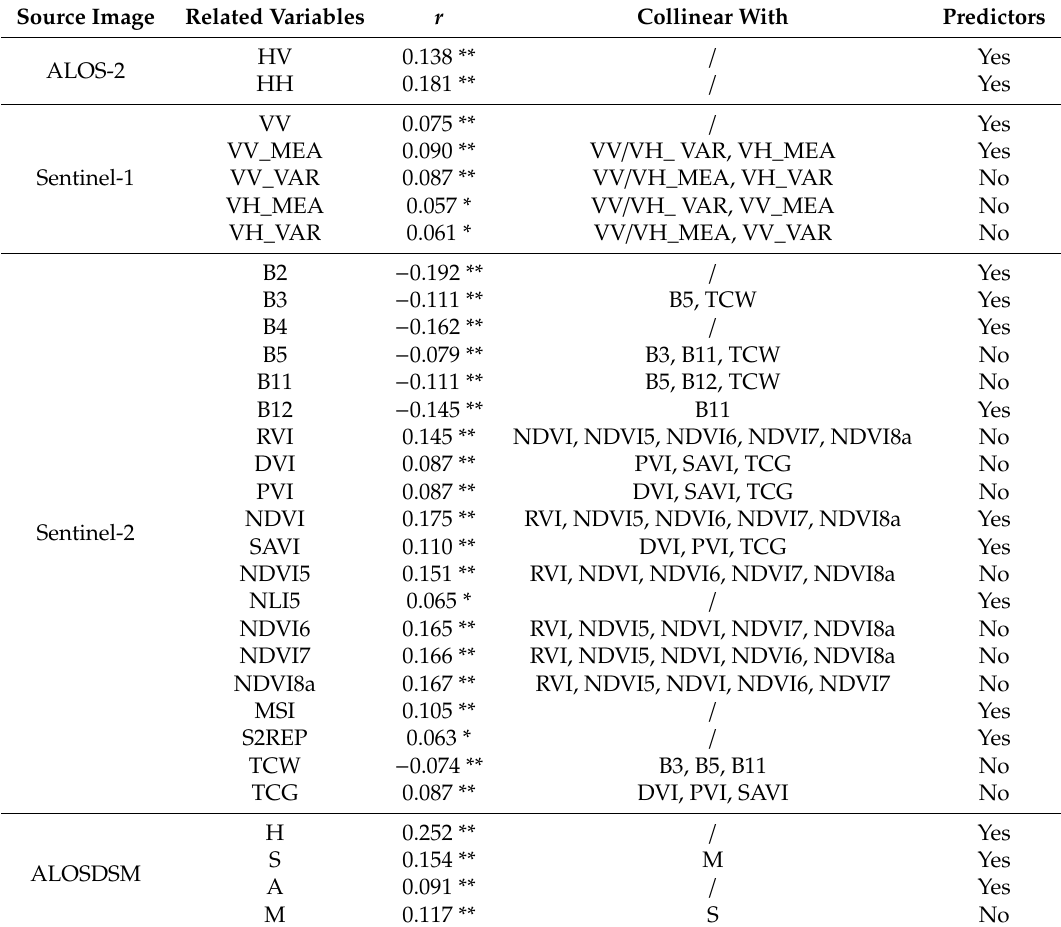
Table 3. Related variables and predictors derived from multi-sensor satellite data for stand volume mapping. * denotes significance with a p -value of the t-test being below 0.05; ** denotes strong significance with a p -value below